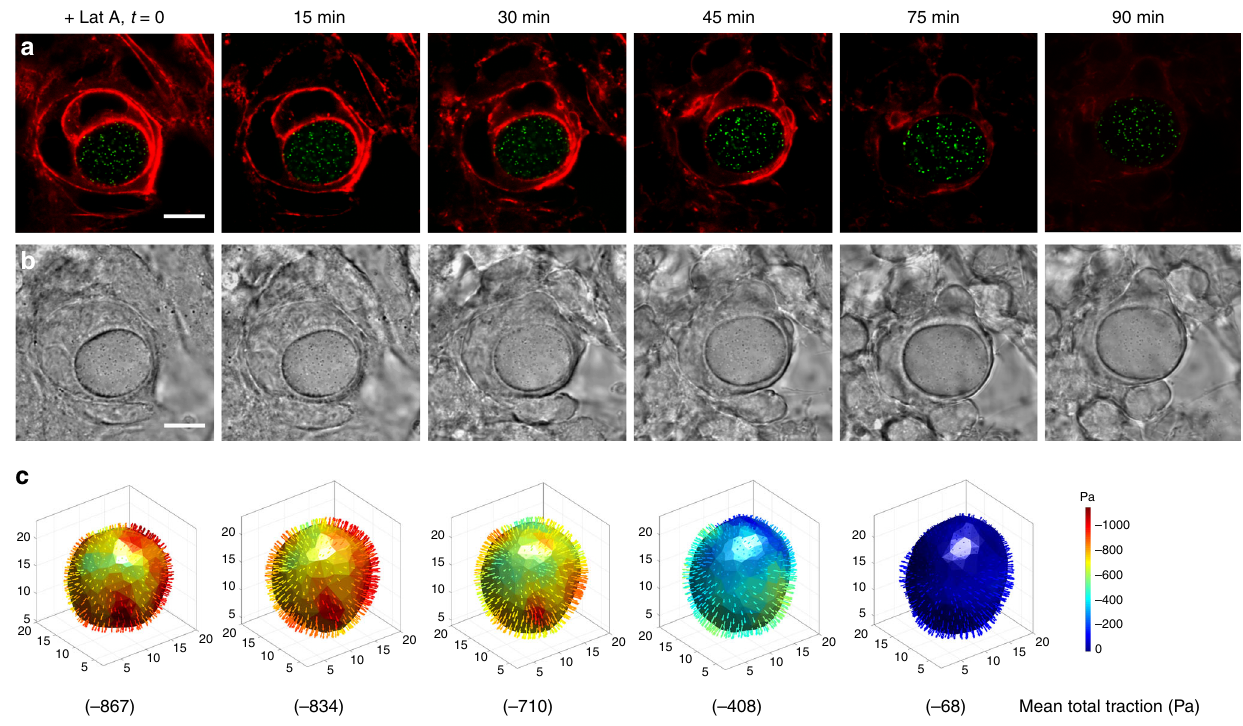
Fig. 3 Tension in F-actin rings around the microgel is responsible for compression. a Representative fl uorescent images show that treatment with Latrunculin A (1 μ M fi nal concentration) gradually dissipated F-actins (red) around the microgel, followed by the expansion of the microgel (green). b The corresponding bright fi eld images of the embedded microgel (Young ’ s modulus of 1440 Pa) in multilayered cells. c 3D total traction maps and its mean value calculated with respect to its reference time at 90 min. The 3D traction maps show that the microgel was gradually decompressed as the fi lamentous actins disappeared. All scale bars, 10 µ